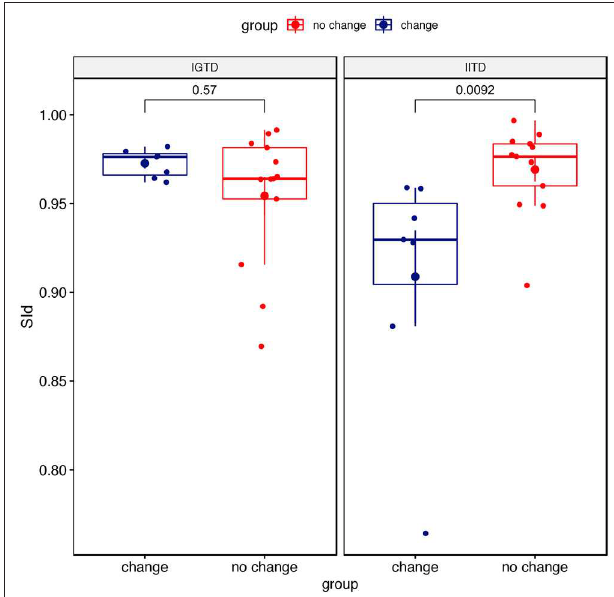
FIGURE 5 | SId from the IITD and IGTD detection methods depending on the change in disease status. The EDSS was not available for one patient.